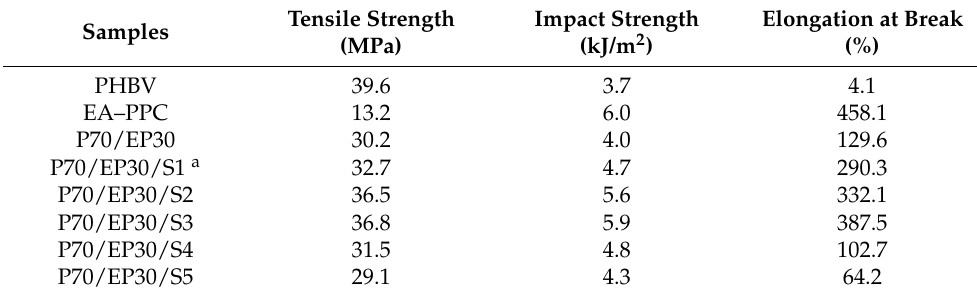
Table 2. Data for the mechanical properties of PHBV/EA–PPC blends.